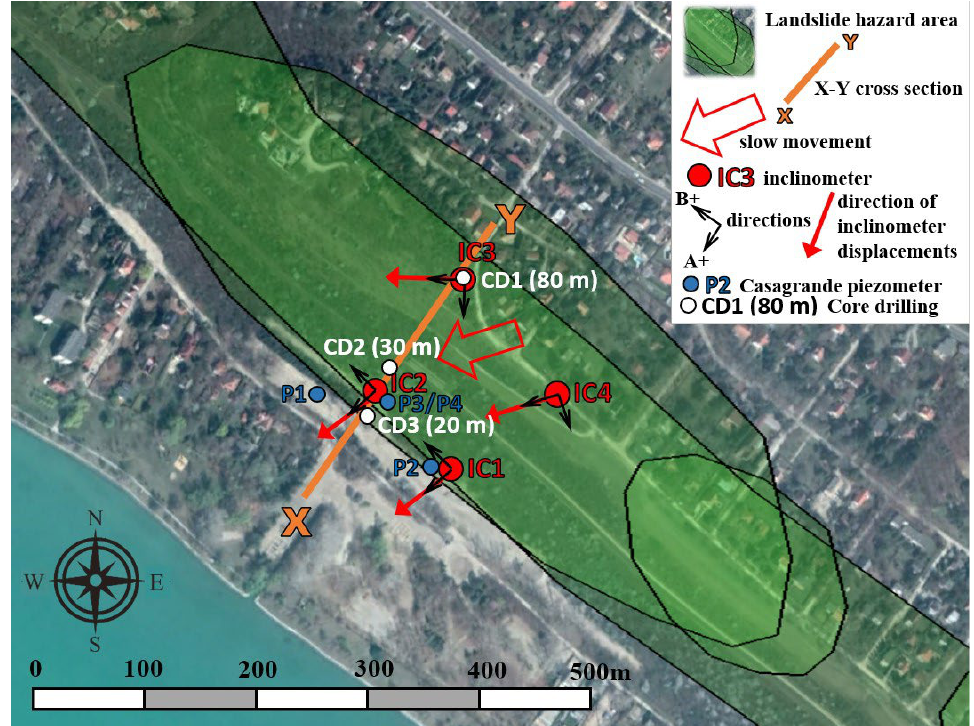
Figure 3. Site plan of the study area with landslide-hazard areas (marked by black lines) according to National Surface Movement Cadastre of Hungary [30] and the location of core drillings, inclinometers and piezometers.